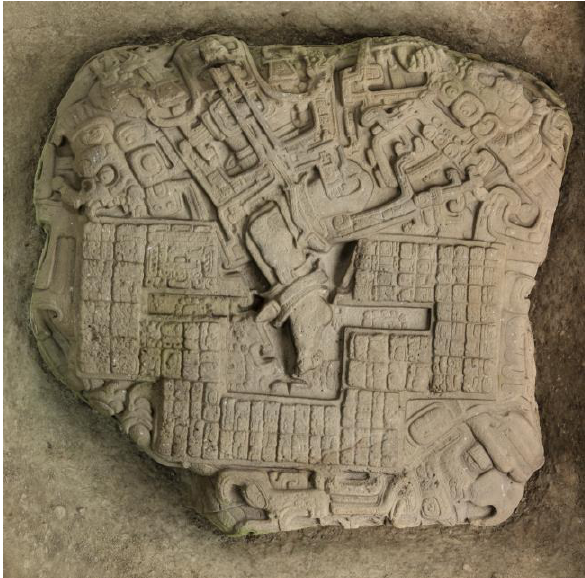
Figure 7. Photogrammetric image of Altar P of Quiriguá, Guatemala. (Project MAYATECH